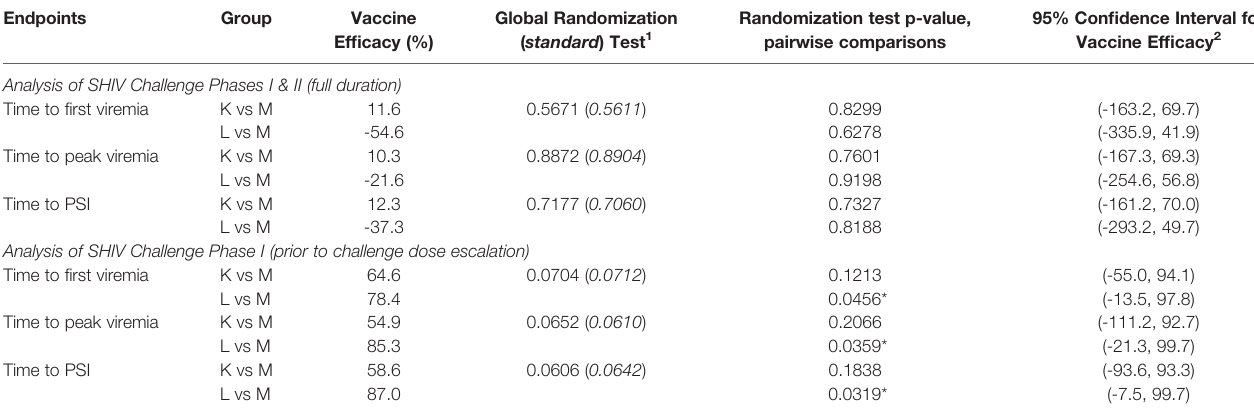
TABLE 2 | Vaccine ef fi cacy estimates and comparisons.